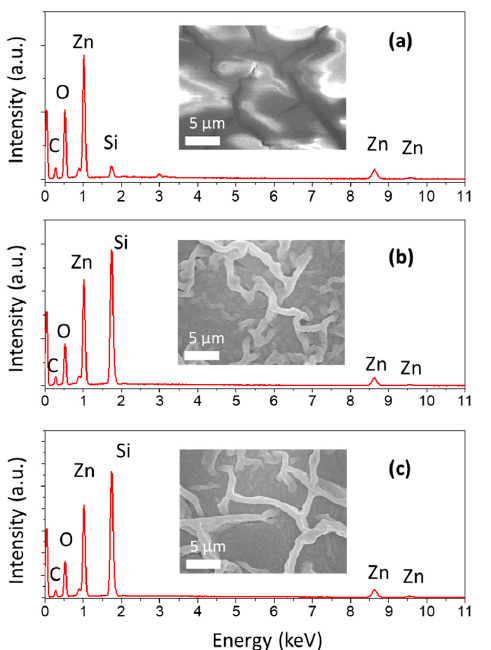
Figure 7. Energy-dispersive X-ray spectroscopy (EDS) analysis of zinc precursor film with different treatment conditions: ( a ) 0 W, ( b ) 4 W, ( c ) 5 W. Insets are FE–SEM images of film morphology according to each condition.